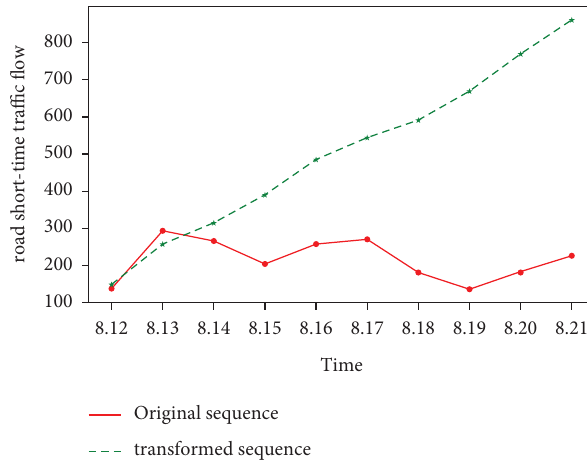
Figure 6: Schematic diagram of the original stochastic oscillation sequence and transformed